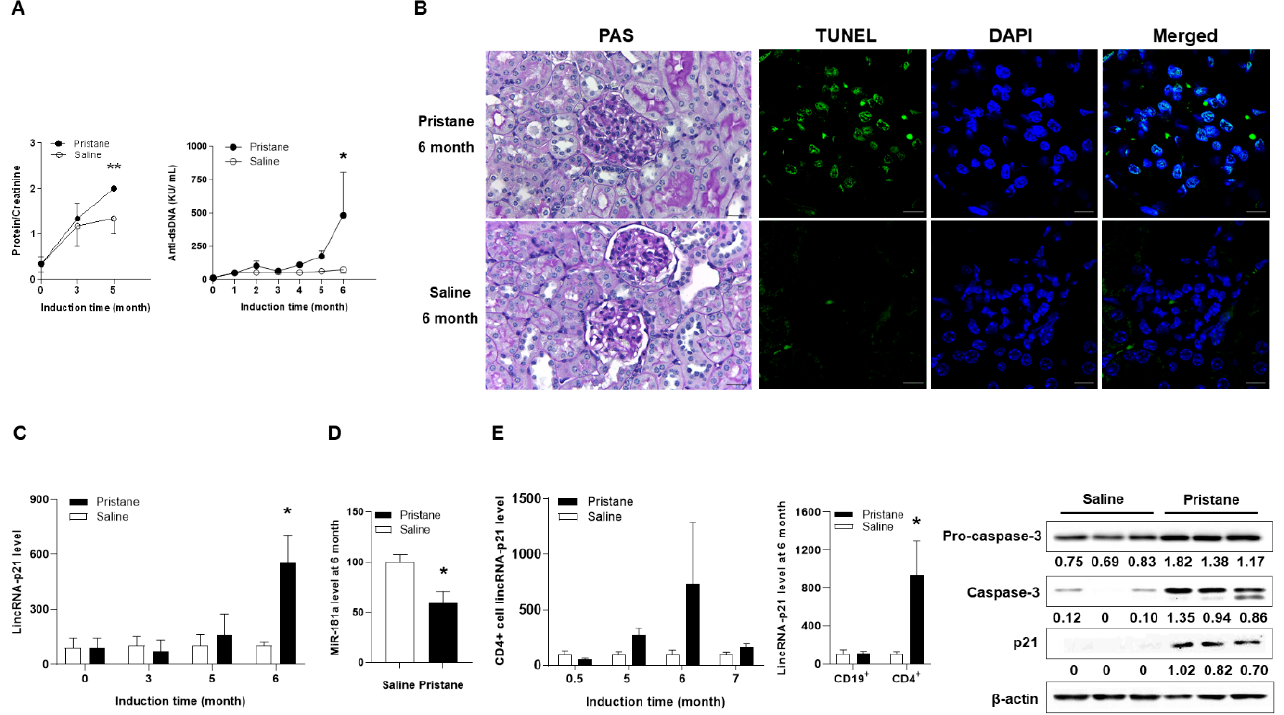
Figure 6. Up-regulated expression of lincRNA-p21 with in situ apoptosis in pristane-induced female Balb/C mice with LN. ( A ) Kinetic measurement of proteinuria amounts and anti-dsDNA titers after pristane induction. Values are the mean ± SEM with 3 mice per group. ( B ) PAS staining of GN with glomerular hyper-cellularity/mesangial expansion (×400) and TUNNEL staining with in situ apoptotic glomerular parenchymal cells (×200) at 6 months after induction. Saline-injected sections as the control (lower panel). Bars shown on photomicrographs at ×200 and ×400 magnification correspond to 20 μ m and 10 μ m, respectively. Representative microphotographs from 3 mice per group. ( C ) Kinetic measurement of lincRNA-p21 levels from kidney cells after induction. Values are the mean + SEM with 5 mice per group. ( D ) Mir-181a levels from kidney cells at 6 months after induction. Values are the mean ± SEM of 5 mice per group. ( E ) Kinetic measurement of lincRNA-p21 levels from CD4+ cells (left panel). LincRNA-p21 levels from CD19+ and CD4+ cells at 6 months after induction (middle panel), and expression of caspase 3 and p21 levels (right panel). Values are the mean ± SEM of 3 mice per group for measurement of lincRNA-p21 levels, and 3 mice per group for caspase 3/p21 immunoblot assay. All of the results in Figure 6 were representative of two independent experiments with similar findings.